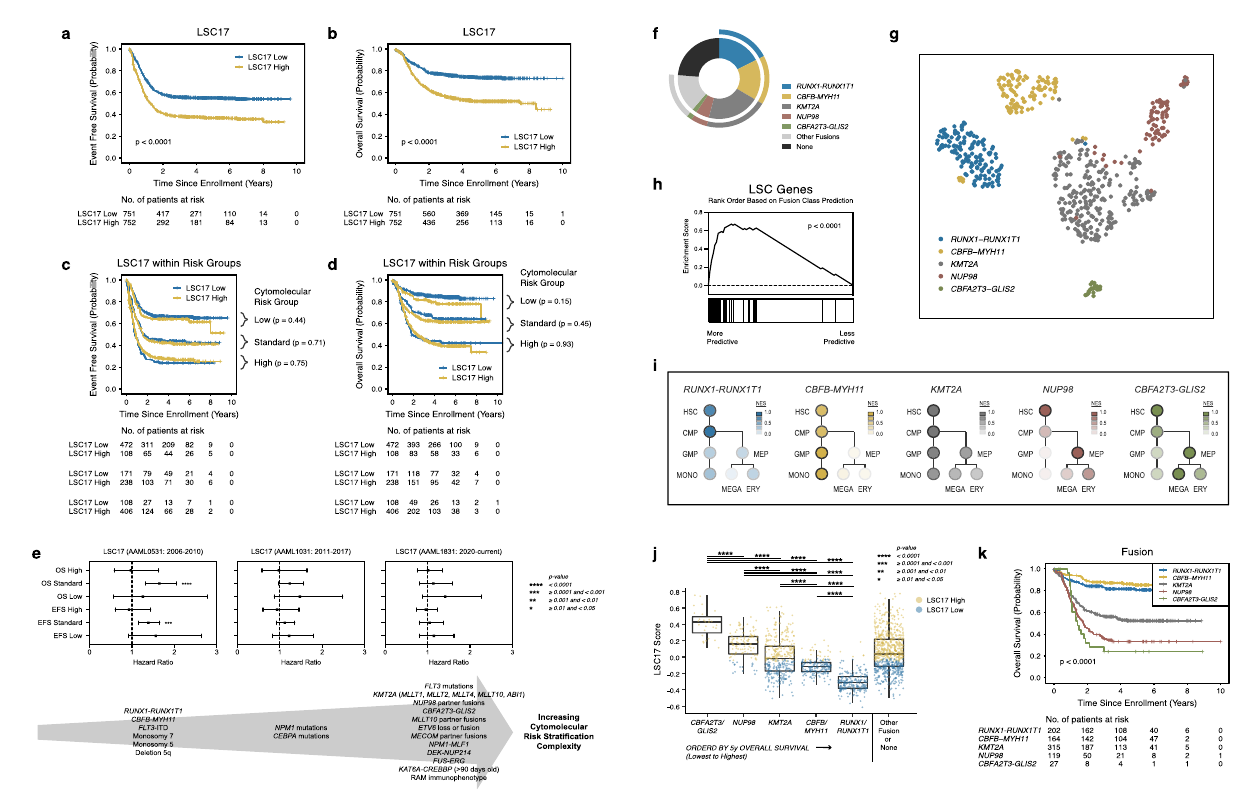
Fig.2|LSC17inpediatricAML. Kaplan – Meierestimatesfortheprobabilityof a EFS and b OS in patients within our entire cohort ( n =1503) strati fi ed based on low versus high LSC17 scores. LSC17 scores signi fi cantly predict survival for the entire non-strati fi ed cohort. Conversely, LSC17 scores do not improve upon previously established risk strati fi cation models based on cytogenetic and molecular altera- tions in regards to either c EFS or d OS. e Hazard ratios with 95% con fi dence intervals for EFS and OS as a function of LSC17 risk group (high versus low) across historical clinical trial cytomolecular risk strati fi cation schema ( n =1503 patients). f Driver gene fusion frequencies within our entire study cohort ( n =1503). g Uniform manifold approximation and projection (UMAP) performedon selected genes based on the nearest shrunken centroids approach clearly discriminates fusion classes. h Gene set enrichment analysis on a 47 LSC gene signature reveals that LSC genes are signi fi cantly enriched among fusion-predictive genes. GSEA p -values are calculated by permutation ( n =1000) across the gene set of interest